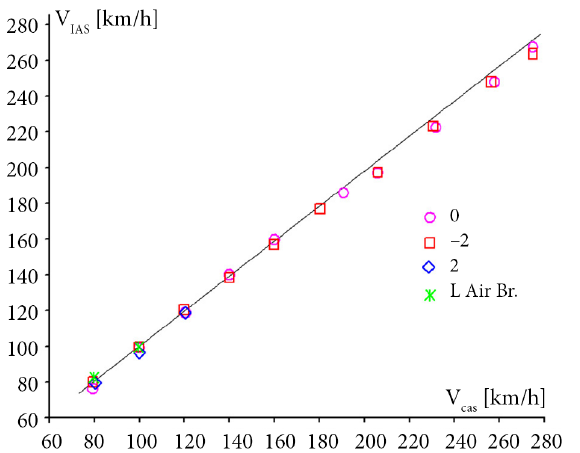
Fig. 16. Test flight results provided by the calibrated airspeed indicator (Figure: K-E. Seegel)